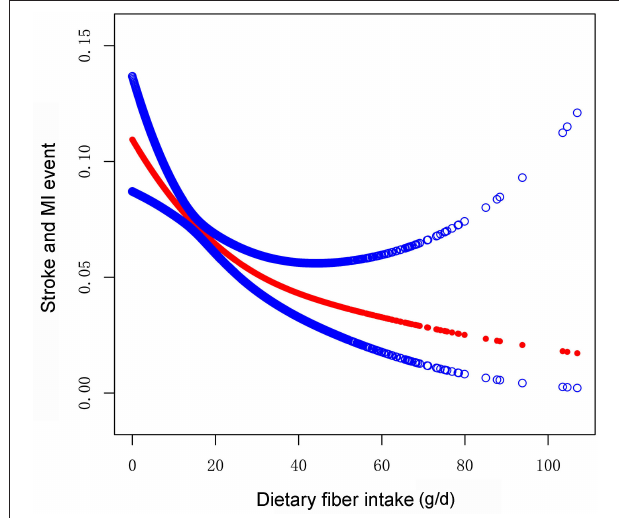
FIGURE 2 | Association between dietary fiber intake and odds of nonfatal cardiovascular event (stroke and MI) using the generalized additive model. Adjusting for potential confounding variables (age; sex; race; marital status; educational level; PIR; BMI; smoking status; systolic blood pressure; diastolic blood pressure; glucose, cholesterol, triglyceride, HDL, and glycohemoglobin levels; energy intake; vigorous activity; diabetes; hypertension; hypercholesterolemia; sleeping disorder; and hypoglycemic, antihypertensive, lipid-lowing, and aspirin drugs). The red points line represents the fitting spline. The blue points line represents the 95% confidence intervals. MI, myocardial